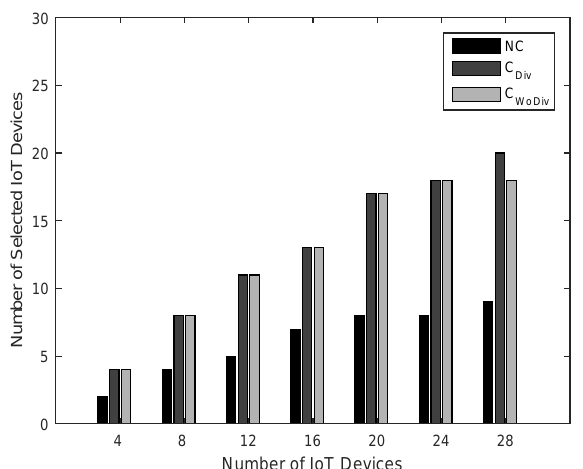
Figure 7. No. of admitted devices with respect to different number of total devices, with 10 relays and minimum device data rate of 1